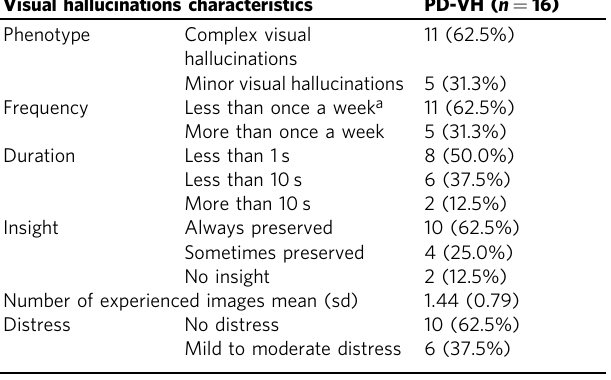
propensity ( Integrated : H = 1.065, p = 0.587, Segregated : H = 4.400, p = 0.111).